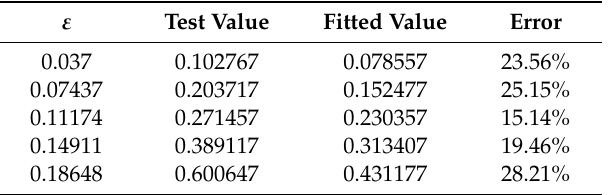
Table 11. The deviation between the test and calculated values for specimen 2 under 200 ◦ C.